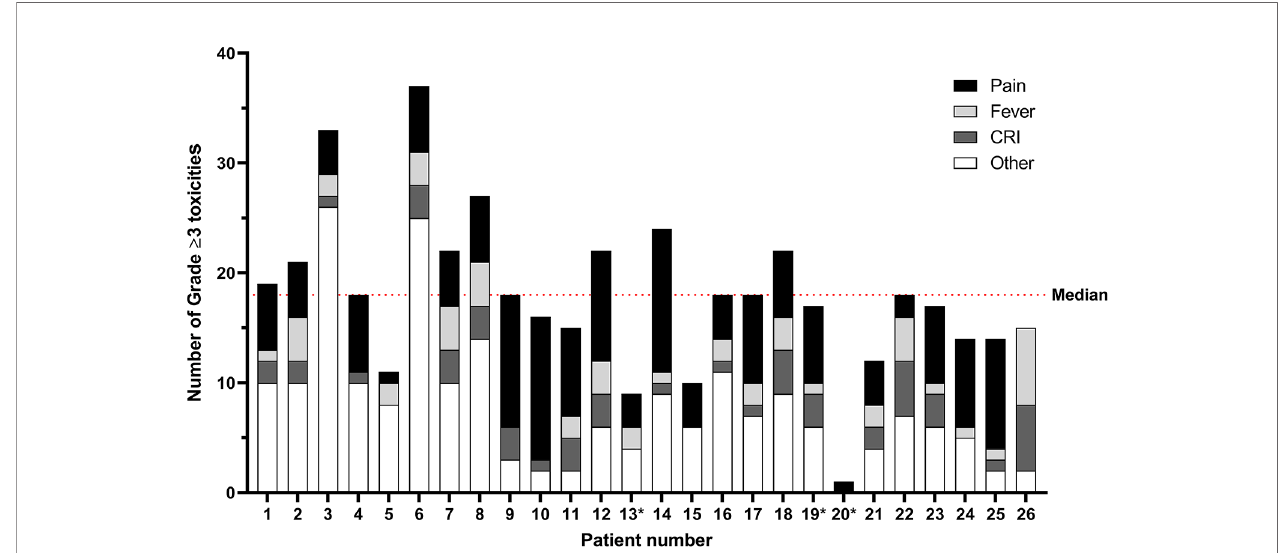
FIGURE 2 | Immunotherapy-related grade ≥ 3 toxicities per patient for courses 1 – 5. Toxicities may be documented multiple times per course, with a maximum of once per day. The median number of grade ≥ 3 toxicities per patient is 18 (range 10 – 37) for the 23 patients who completed all six courses of immunotherapy. The category “ Other ” comprises toxicities in alphabetical order from the CTCAE categories Allergy; Blood/bone marrow; Constitutional, Cardiac; Gastrointestinal, Infection; Lymphatics; Metabolic/laboratory; Neurology; Ocular/visual; Pulmonary; and Vascular. All individual toxicities encountered are listed in Supplementary Table 2 . *Patients 13, 19, and 20 did not complete all cycles of immunotherapy. CRI, catheter-related infections.